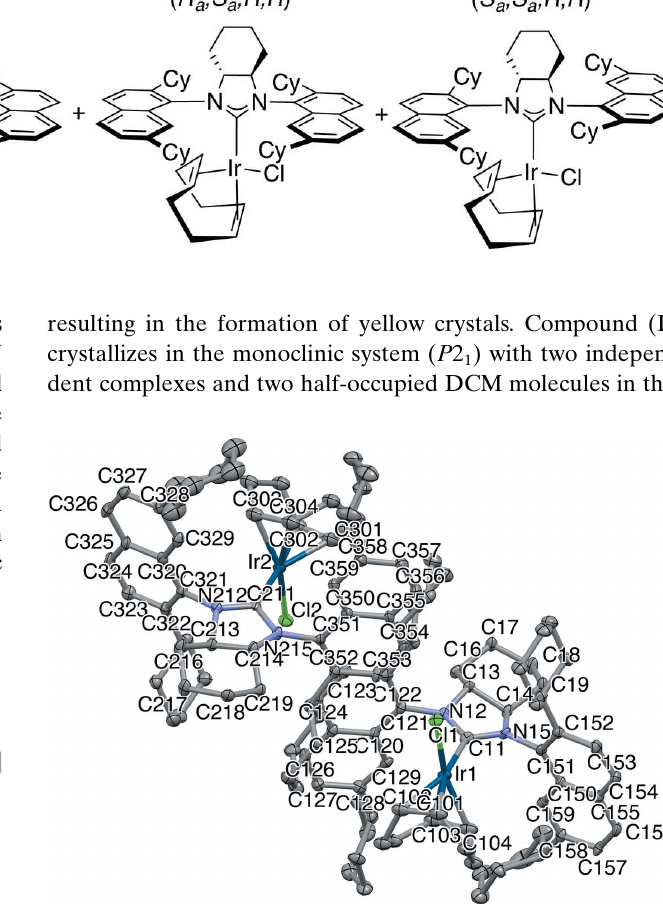
Figure 2 The molecular structures of the title complex (I) with atom labelling. Labelling of selected aliphatic carbons has been omitted for clarity. Ellipsoids are drawn at the 50% probability level. H atoms have been omitted for clarity.